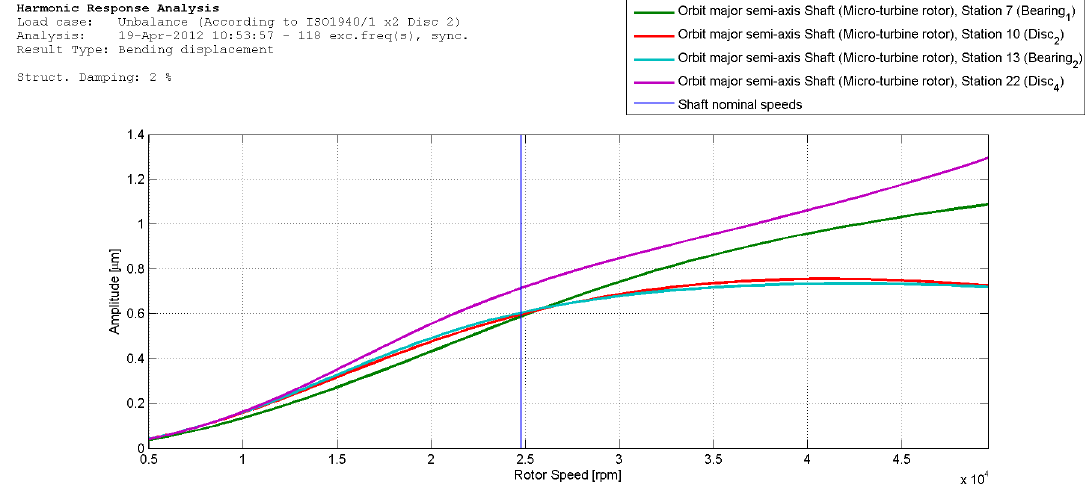
Figure 9: Amplitude of the rotor vibration for the unbalance of the disc No. 2 equal to 2.4 × 10 −6 kg · m.